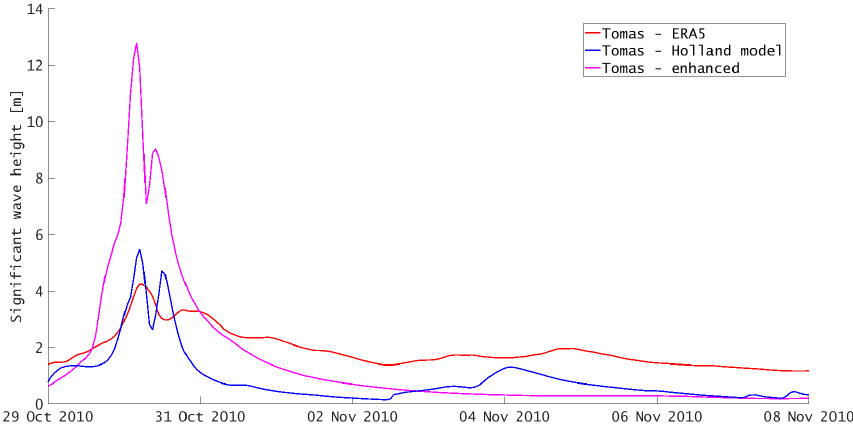
Figure 8. Significant wave height at Argyle International Airport during Hurricane Tomas: red line – wave model run forced with the ERA5 reanalysis; blue line – wave model forced with the Holland’s model parametric winds; pink line – wave model forced with worst-case-scenario enhanced